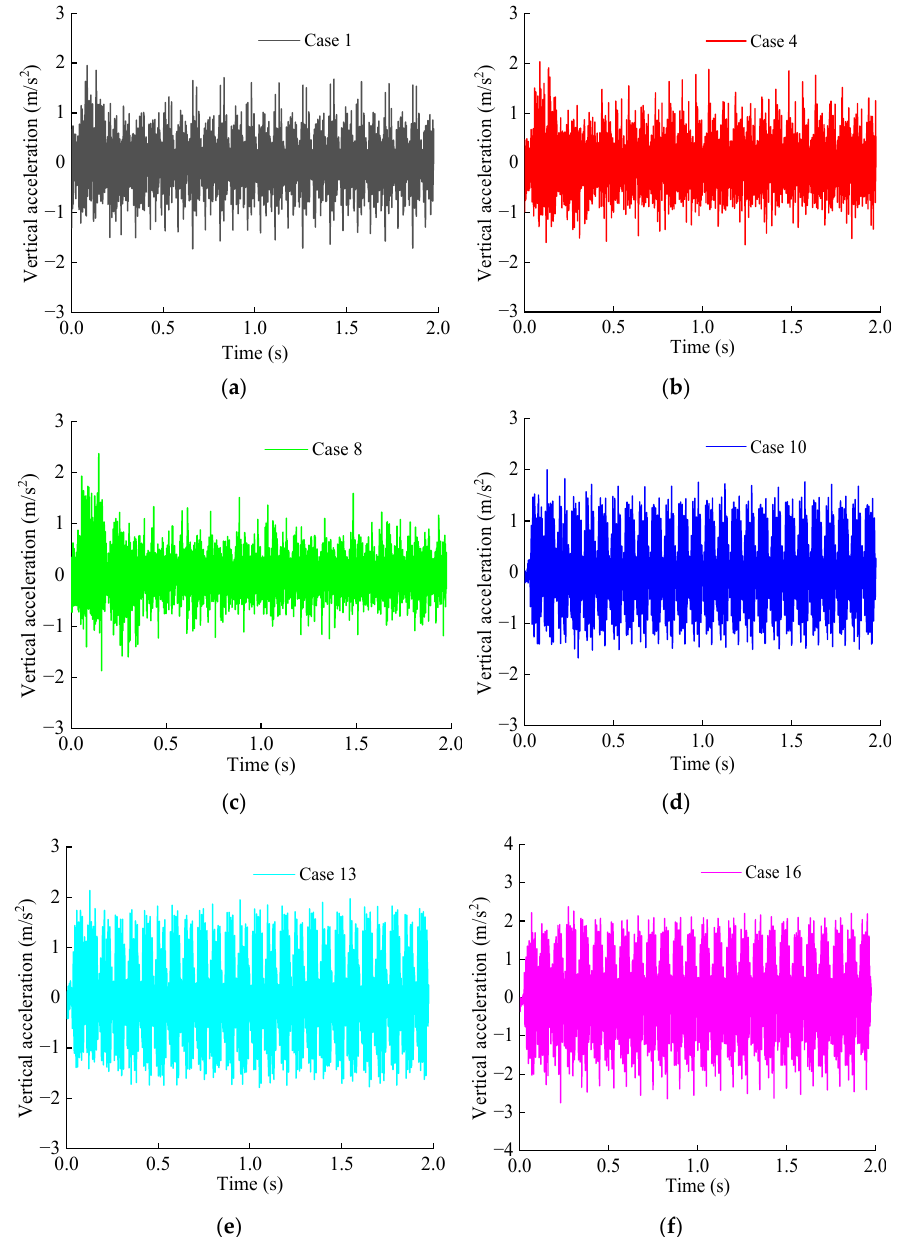
Figure 11. Vertical acceleration time–history curve of measuring point B: ( a ) Case 1; ( b ) Case 4; ( c ) Case 8; ( d ) Case 10; ( e ) Case 13; ( f ) Case 16.